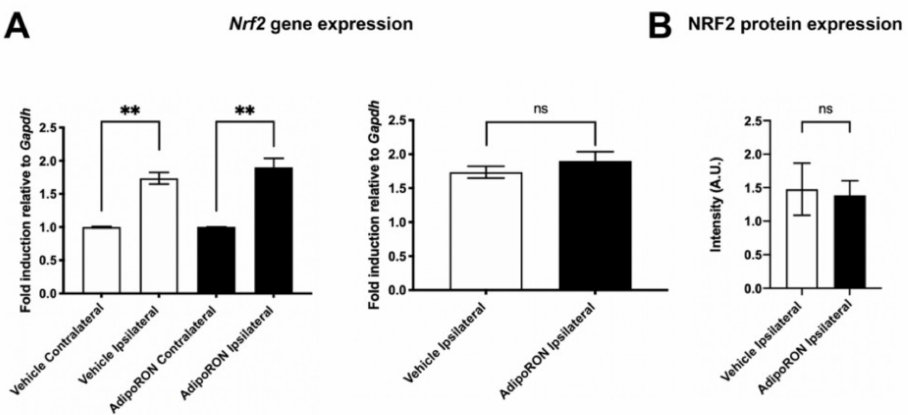
Figure 8. AdipoRON did not change the gene and protein expression of Nrf2 in the ischemic hemi- sphere compared to control mice. ( A ) Nrf2 gene expression is up-regulated in the ipsilateral hemi- sphere compared to the contralateral one in both Vehicle and AdipoRON-treated group. Note that Nrf2 gene expression remains similar in the ipsilateral hemisphere of both groups. ( B ) NRF2 protein expression in the ipsilateral hemisphere is unchanged 24 h post-stroke in Vehicle and AdipoRON- treated mice ( n = 3). ** p <